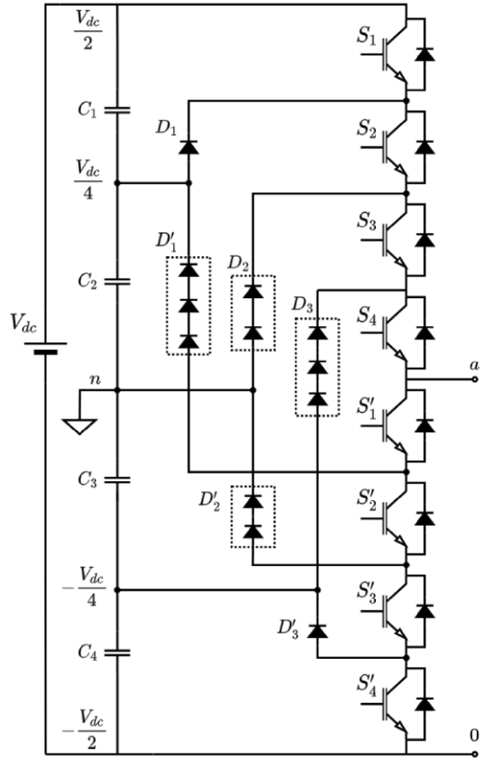
Figure 13. Five-level diode-clamped voltage source converter (1 phase).